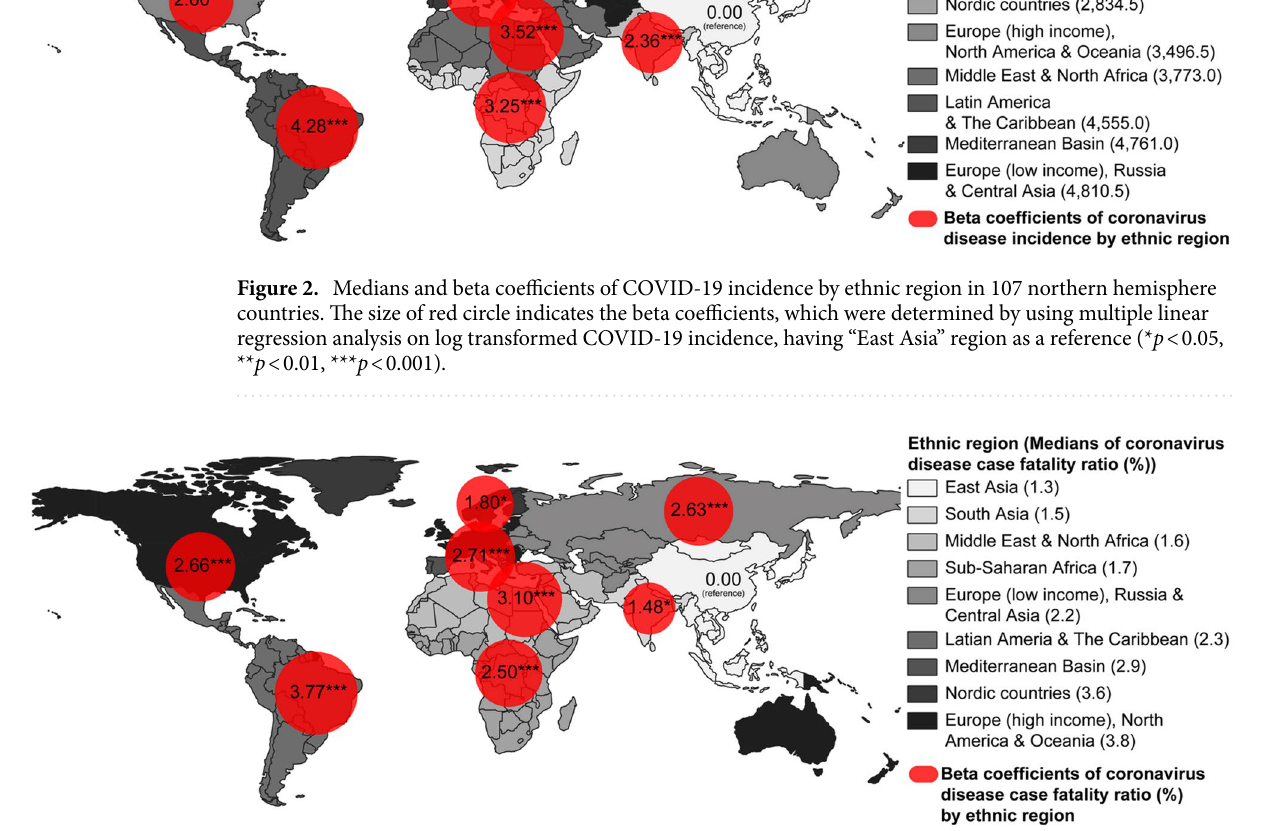
Figure 3. Medians and beta coefficients of COVID-19 case-fatality ratio (%) by ethnic region in 107 northern hemisphere countries. The size of red circle indicates the beta coefficients, which were determined by